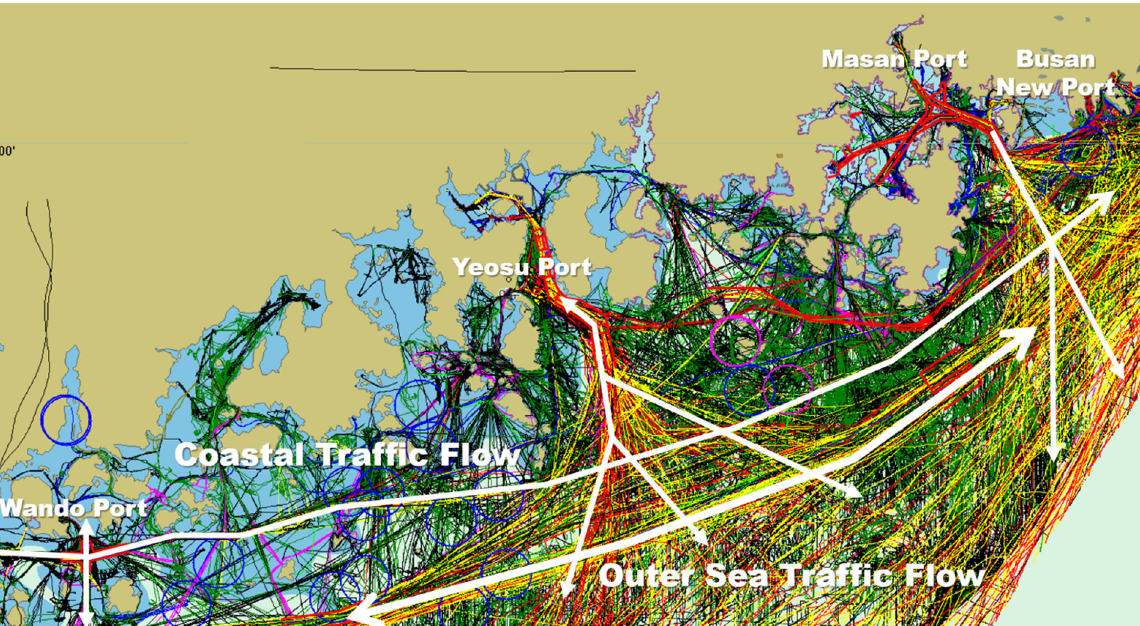
Figure 1. Flowchart of the study.